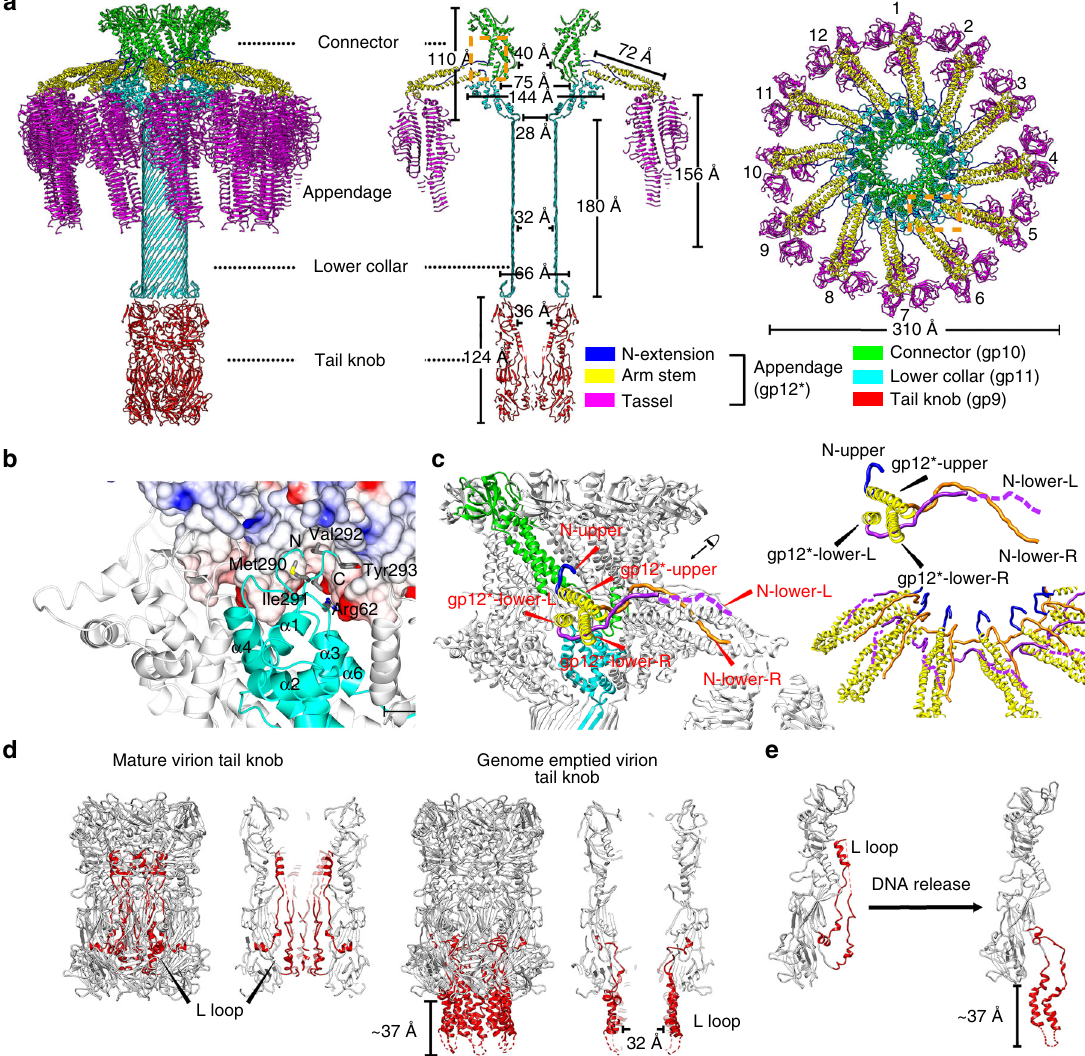
Fig. 8 Structures and organizations of the collar complex and the tail knob. a Ribbon diagrams showing the overall organization and structure of the entire tail. Components of the tail are colored differently (connector: green, lower collar: cyan, N-extensions of tail appendages: blue, arm stems of tail appendages: yellow, tassels of tail appendages: magenta and tail knob: red). b Ribbon and shadowed-surface diagrams showing the interactions between the connector and the lower collar. The connector is shown in shadowed-surface colored by electrostatic potentials as in Fig. 5e. c Zoom-in showing the interlocked assembly of the tail appendages. Three N-terminus of each tail appendage are colored differently (N-upper: blue, N-lower-L: purple, N-lower-R: orange). The arm stems of the tail appendages are colored yellow. One connector monomer and one lower collar monomer are colored green and cyan, respectively. d Ribbon diagrams showing the tail knob structures. The hydrophobic L-loops are color red. The disordered regions of the L-loops (residues 440 – 455) are represented with dashed red lines. e Ribbon diagram showing the conformational change of L-loops upon genome